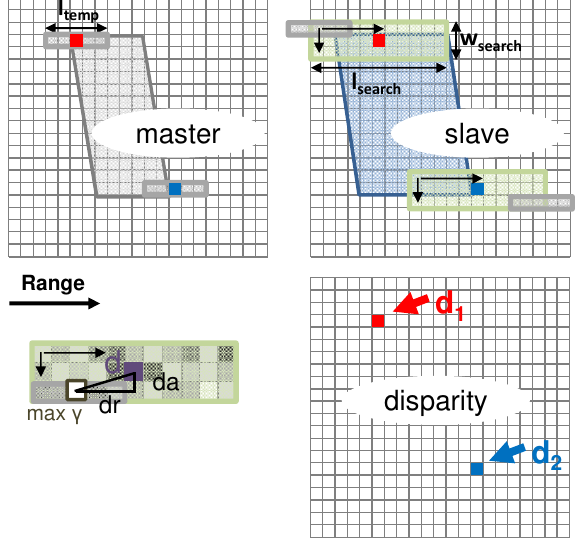
Figure 3: Schematic representation of disparity map calculation, with corresponding